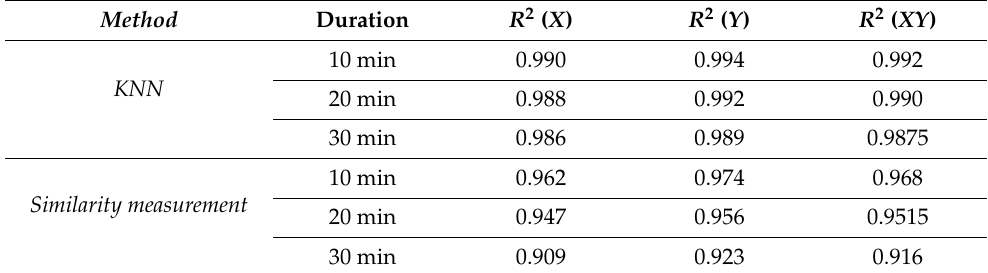
Table 4. The values of R 2 to X , Y , or XY merged by evaluation in different durations.